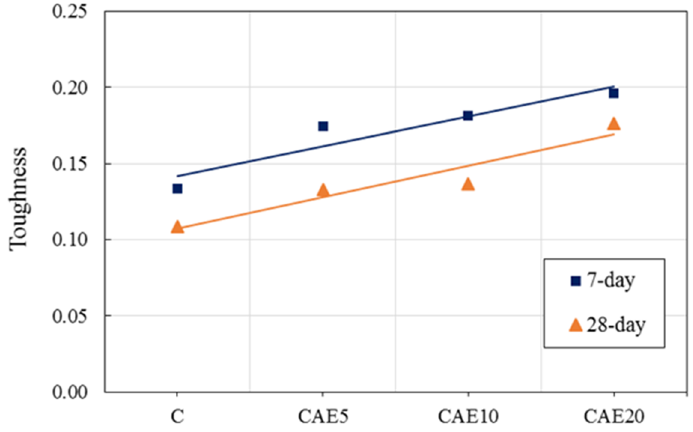
Figure 8. The linear lines of flexural-to-compressive strength ratio.